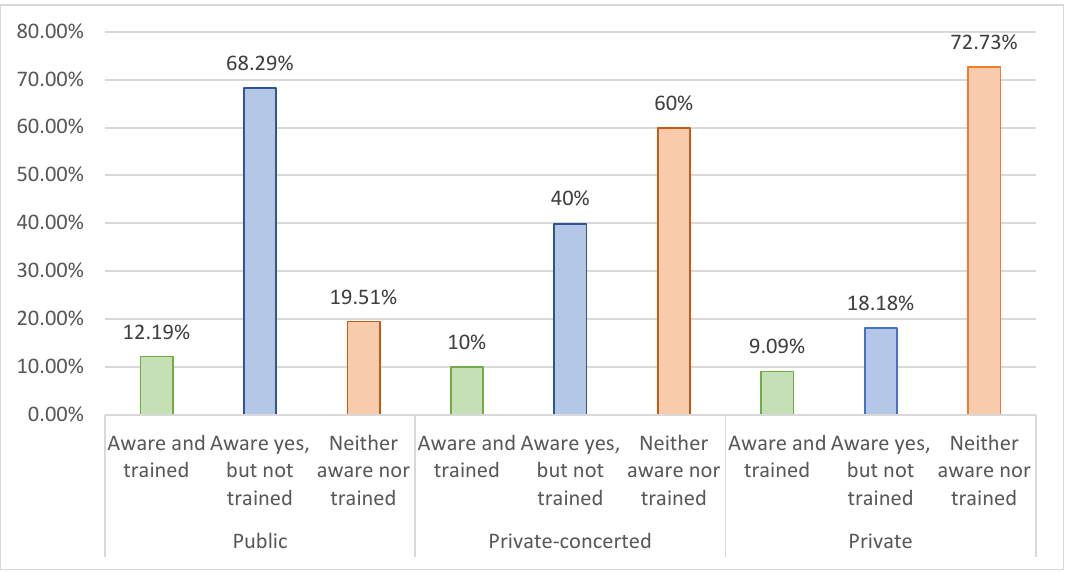
Figure 3. Level of teacher awareness and training according to school ownership.